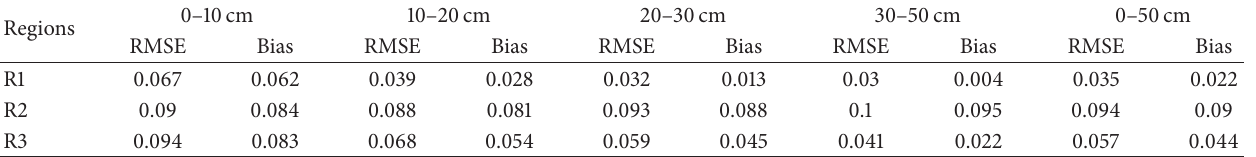
Figure 2: Spatial distribution of the simulated mean and measured SM for April to November of 1981–1999 (unit: m 3 /m 3 ). (a) CLM4.0 simulated SM (0–9.06 cm); (b) measured SM (0–10 cm); (c) CLM4.0 simulated SM (0–49.3 cm); (d) measured SM (0–50 cm); (e) bias percent between CLM4.0 simulated (0–9.06 cm) and measured (0–10cm) SM; and (f) bias percent between CLM4.0 simulated (0–49.3 cm) and measured (0–50cm) SM. Table 2: The RMSE and bias between simulated monthly mean and measured SM of each layer over the subregions (unit: m 3 /m 3 ).